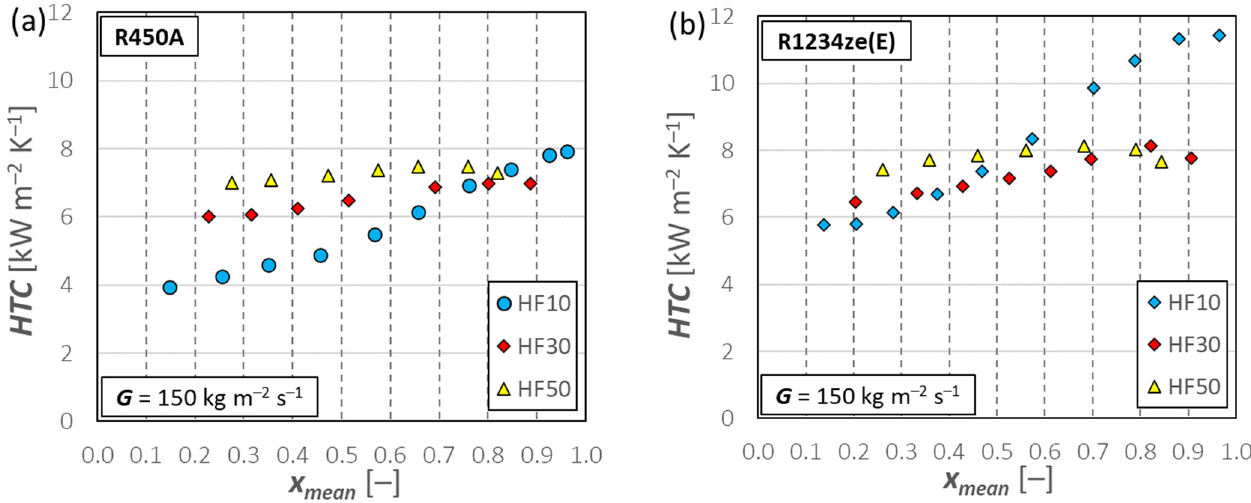
Figure 4. Heat transfer coefficient vs. mean vapor quality at t sat = 30 °C at G = 150 kg m − 2 s − 1 for R450A ( a ) and R1234ze(E) ( b ). HF10 = 10 kW m − 2 , HF30 = 30 kW m − 2 , and HF50 = 50 kW m − 2 .